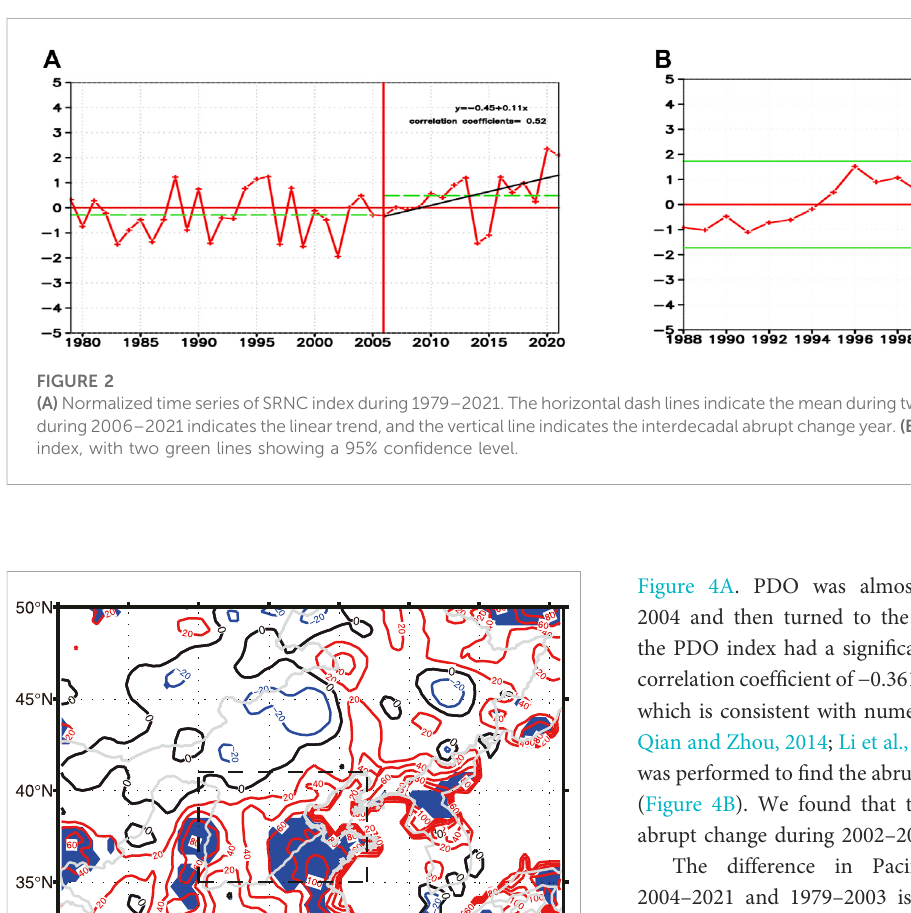
abrupt change during 2002 – 2004.